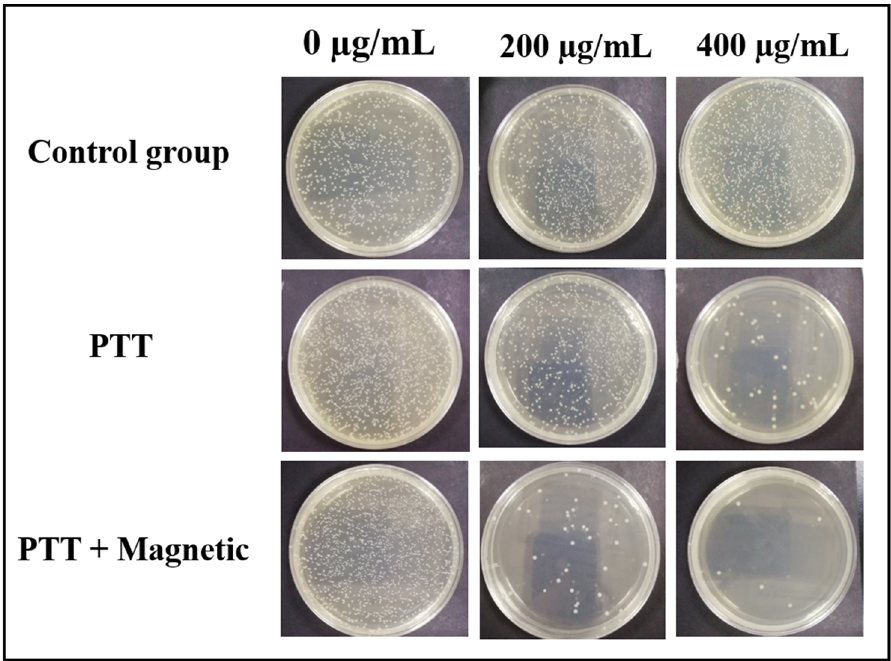
Figure 9. Co-culture results of Fe 3 O 4 @SiO 2 @Au/PDA nanochains with Escherichia coli at different concentrations and under different treatment conditions. concentrations and under different treatment